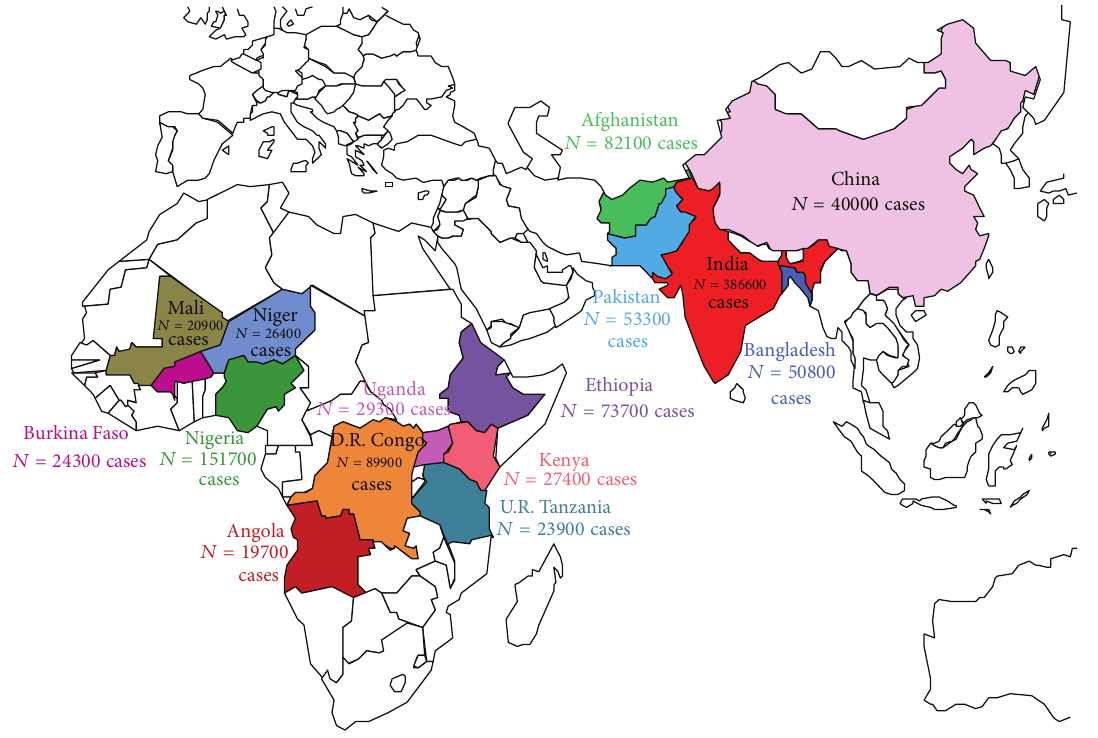
Figure 1: Countries with highest numbers of infantile deaths due to acute diarrhoea. Adapted from